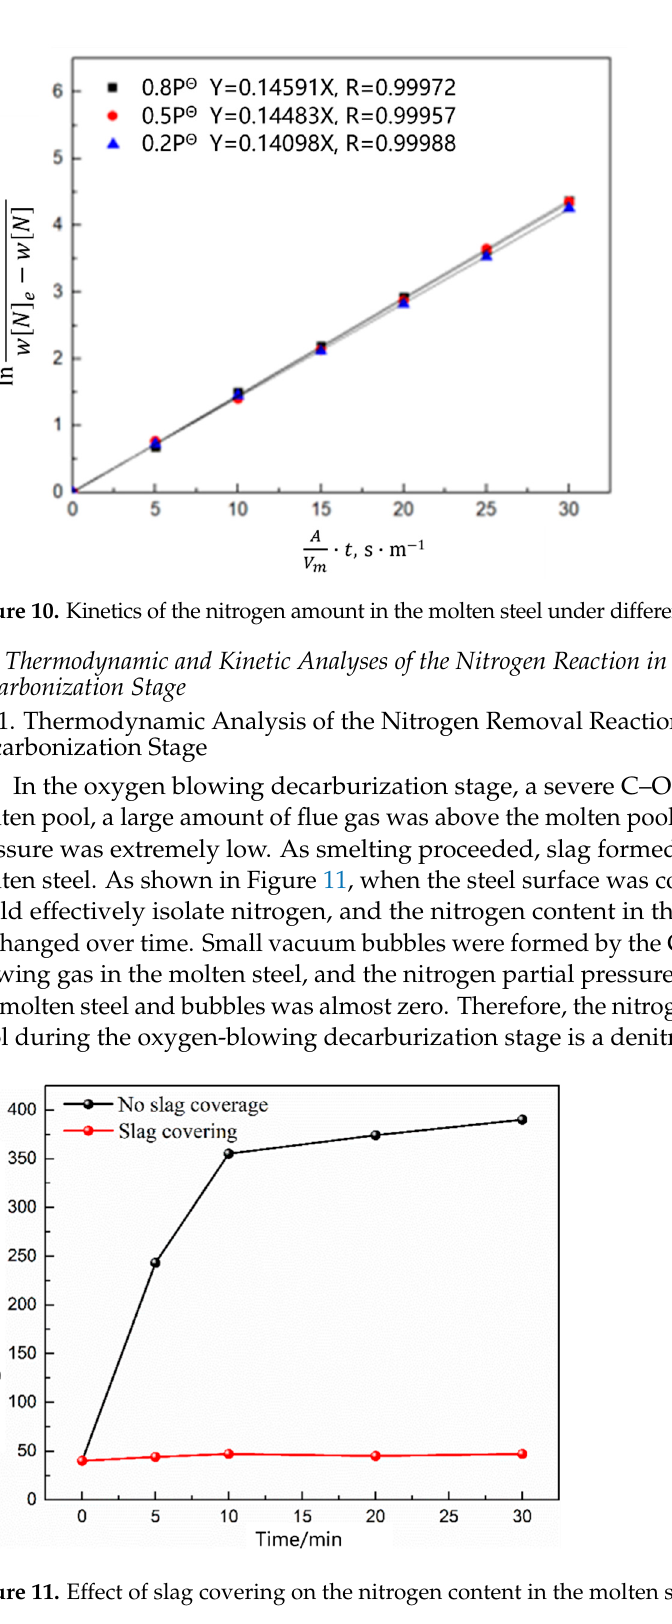
Figure 11. Effect of slag covering on the nitrogen content in the molten steel.